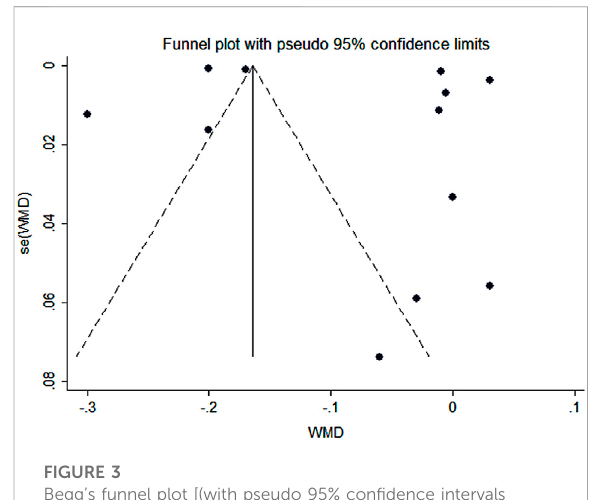
FIGURE 3 Begg ’ s funnel plot [(with pseudo 95% con fi dence intervals (CIs)] of the weighted mean difference (WMD) versus the standard error (se) of WMD for the comparison of LTL in children and adolescents with or without overweight/obesity (P begg = 0.583; P egger = p =